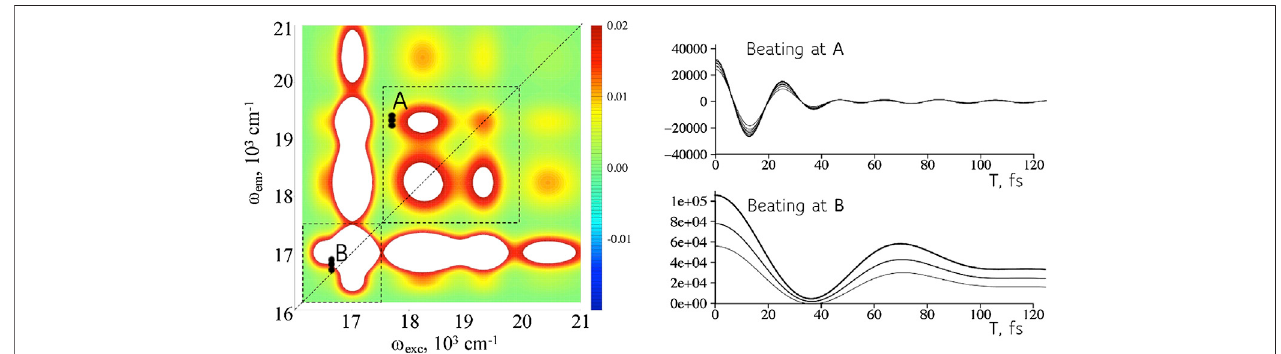
FIGURE 4 | The same device can simulate a range of frequencies. Left: A 2D frequency map (real part) for the device at a particular value of the time interval T (computed for the full frequency range of the excited states, Supplementary Figure S4 ). The dispersion in sizes means that there is a range of frequencies corresponding to each coherence. Point A. A higher frequency coherence, more off the diagonal in the map, used to compute the time-evolution of the bond distance, Figures 3A,B . Shown are the intensities of the coherence vs time T for points in the range shown on the map. Point B. Coherence at a lower frequency for the computation of the bond dispersion, Figures 3C,D . A wider range in the frequency is possible but reading nearer to the diagonal is experimentally more challenging.